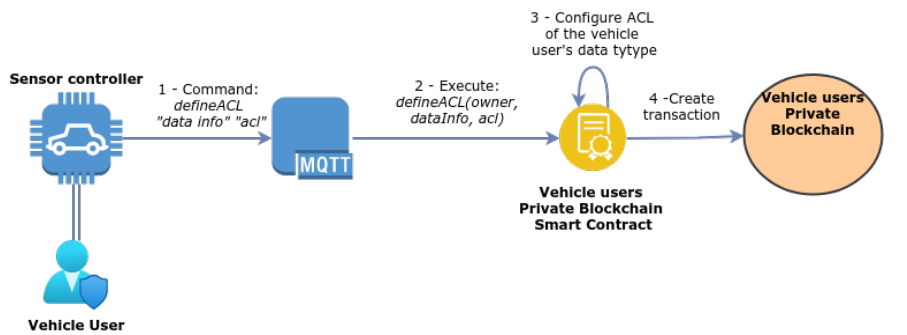
Figure 3. Vehicle user’s ACL definition.